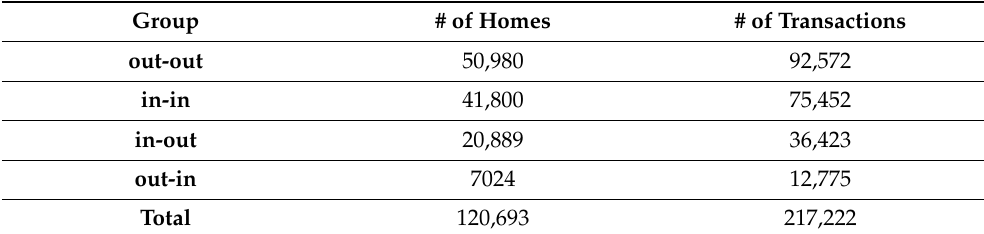
Table 1. The number of unique single-family homes sold and the number of transactions in each SFHA change category from 2005–2011.